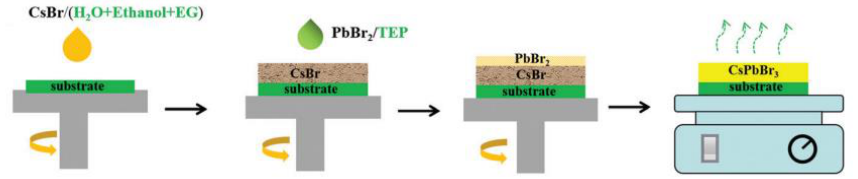
Figure 12. Schematic image of the fabrication process of CsPbBr 3 films through an anomalous route using all-green solvents [32].